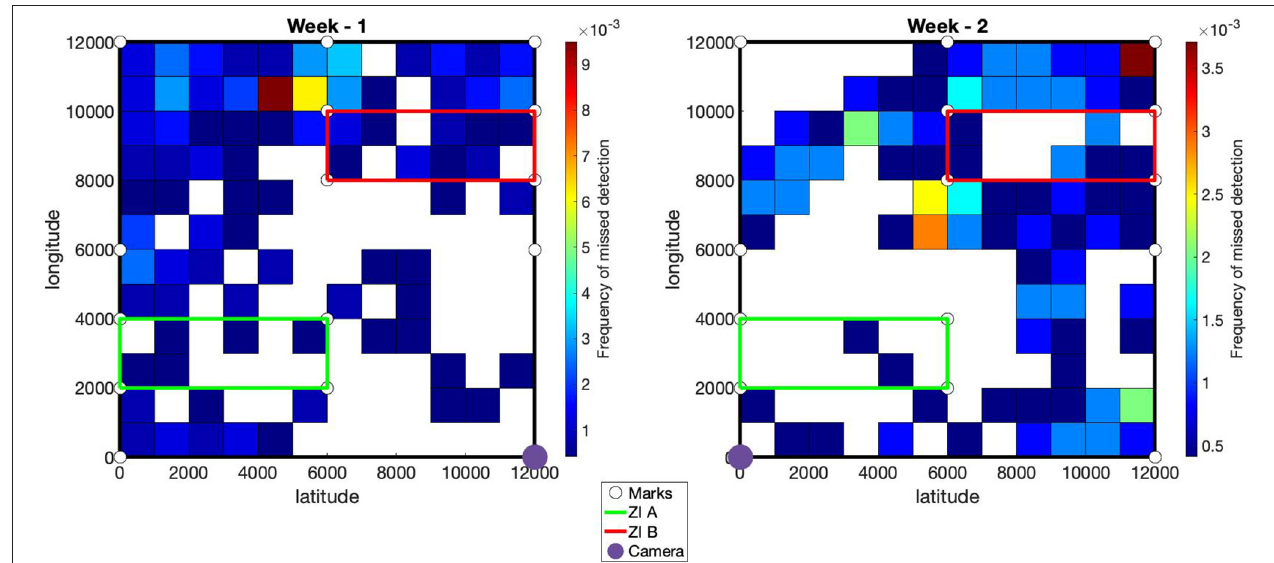
FIGURE 4 | Spatial frequency of missed detections. The pasture is delimited by the black lines. The green and red lines define infected areas A and B. The white disks provide the locations of the marks used to fit the geometric transformation from pixels to spatial coordinates. For each week, the location of the camera is defined by the purple disk.